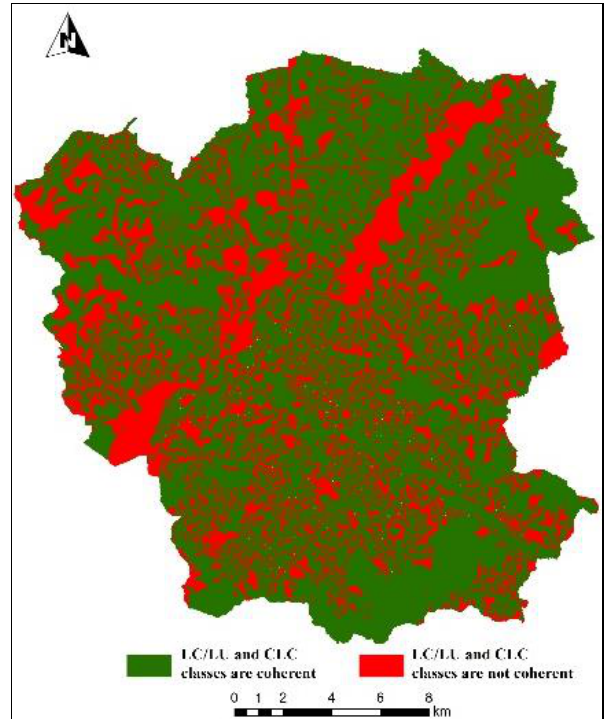
Figure 6 . The spatial distribution of coherency between LC/LU and